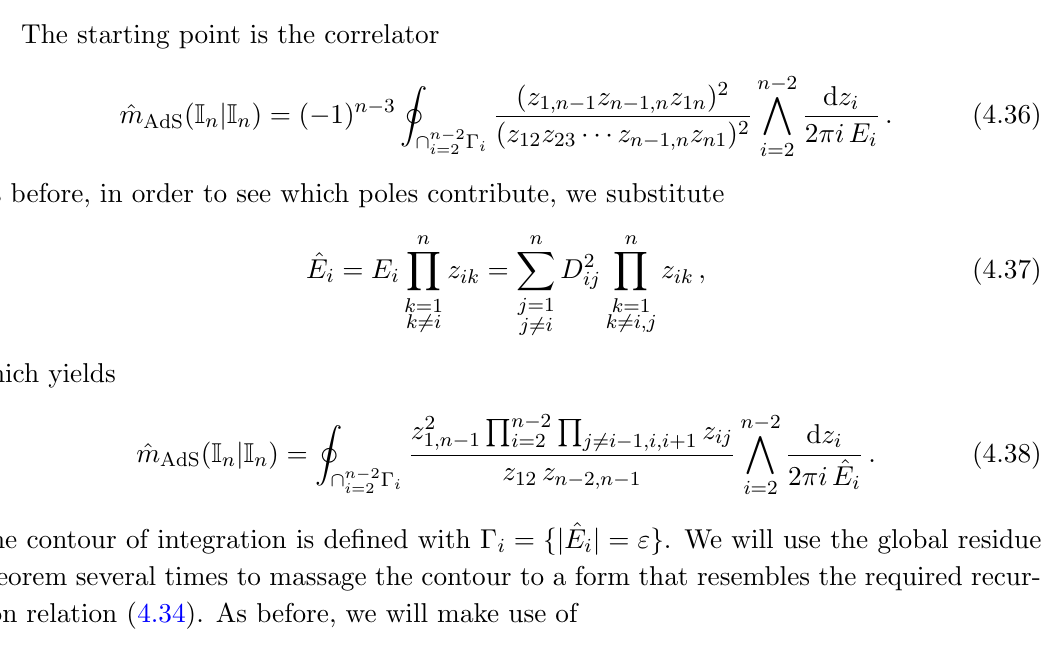
D i = 0 for each term on i